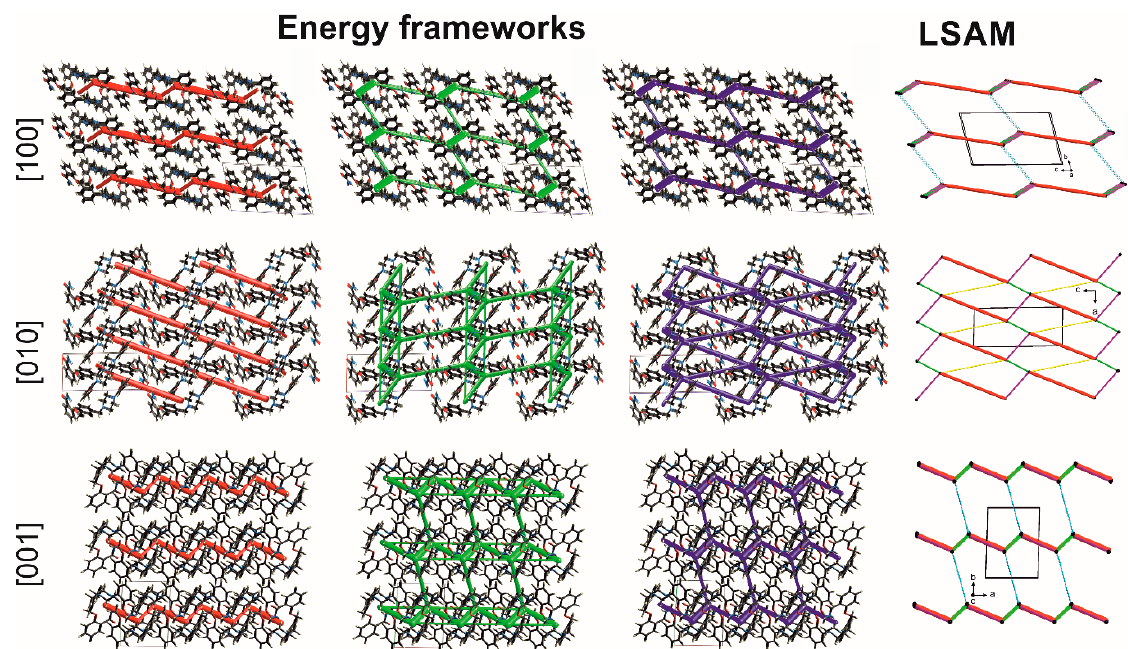
Figure 8. Energy frameworks in 1-MeOH : electrostatic (red) and dispersion (green) contributions to the total energy (blue). Topology of the network (LSAM): black dot represents the center of gravity of molecule 1, lines in agreement with directions of intermolecular interactions (colors correspond to motifs in Figure 7). Views along unit cell basis vectors.